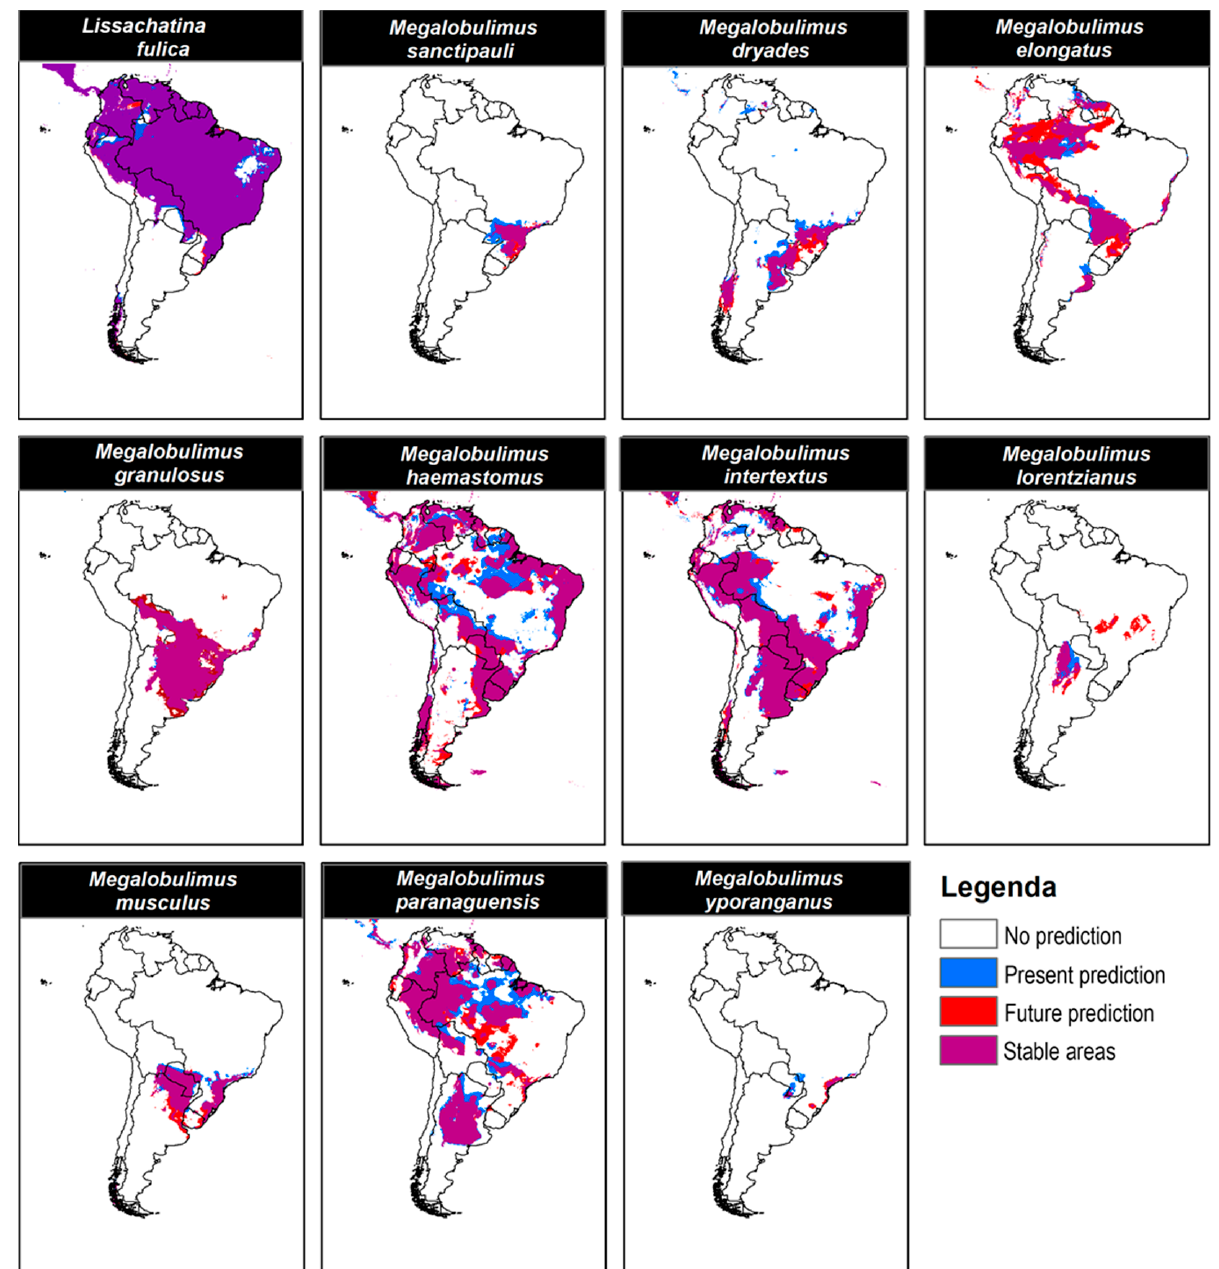
Figure 4. Maps of overlapping potential distribution between current and future (2040–2060) scenarios indicate stable areas (purple), predicted areas under the current scenario (blue), and predicted areas only in future scenarios (red). White regions were predicted to be unsuitable.